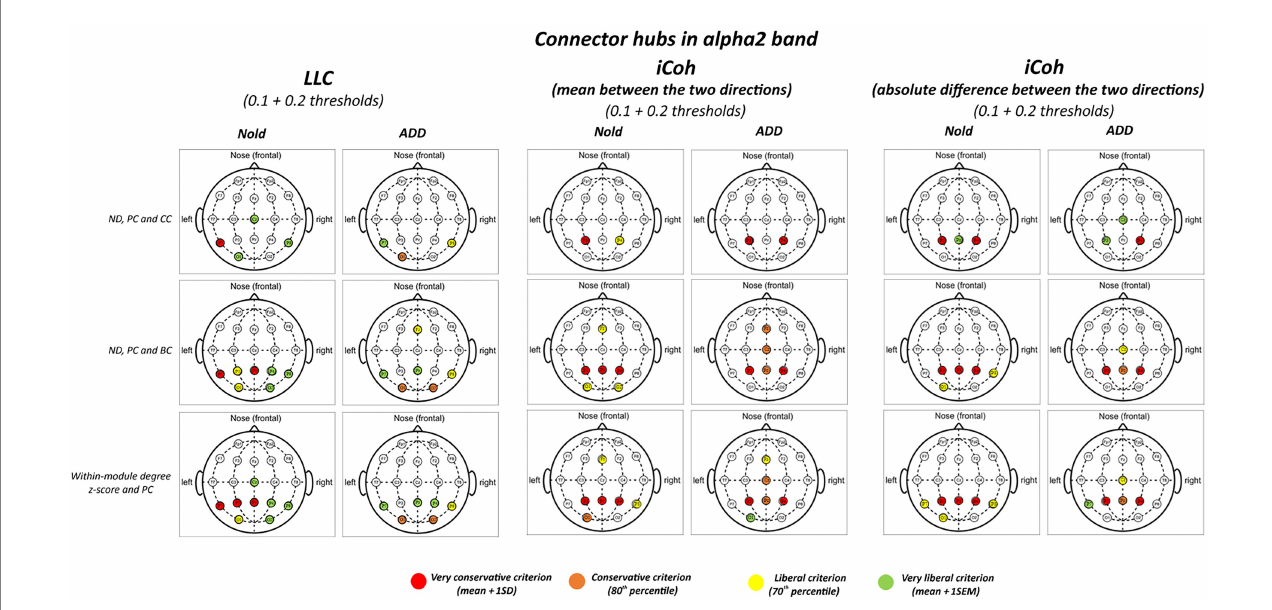
FIGURE 3 Connector and provincial hubs for the alpha 2 linear lagged connectivity (LLC, left column), mean (middle column), and absolute difference isolated lagged effective coherence (iCoh, right column) values in the Nold and ADD groups defined according to the three approaches used in the present study. Upper row: hubs were defined according to nodal degree (ND) and classified into connector and provincial hubs according to the participation coefficient (PC) and clustering coefficient (CC) calculated at 0.1 and 0.2 graph thresholds, in line with the approach described by Franciotti and Bonanni. Middle row: hubs were defined according to nodal degree (ND) and classified into connector and provincial hubs according to the participation coefficient (PC) and betweenness centrality (BC) calculated at 0.1 and 0.2 graph thresholds, in line with the approach described by Cole et al. (2015). Lower row: hubs were defined according to the within-module degree z-score and classified into connector and provincial hubs according to the participation coefficient (PC) calculated at 0.1 and 0.2 graph thresholds, in line with the approach described by Power et al. (2013). Colors correspond to the different criteria adopted (mean and SD, 80th/20th percentile, 70th/30th percentile, mean and SEM).